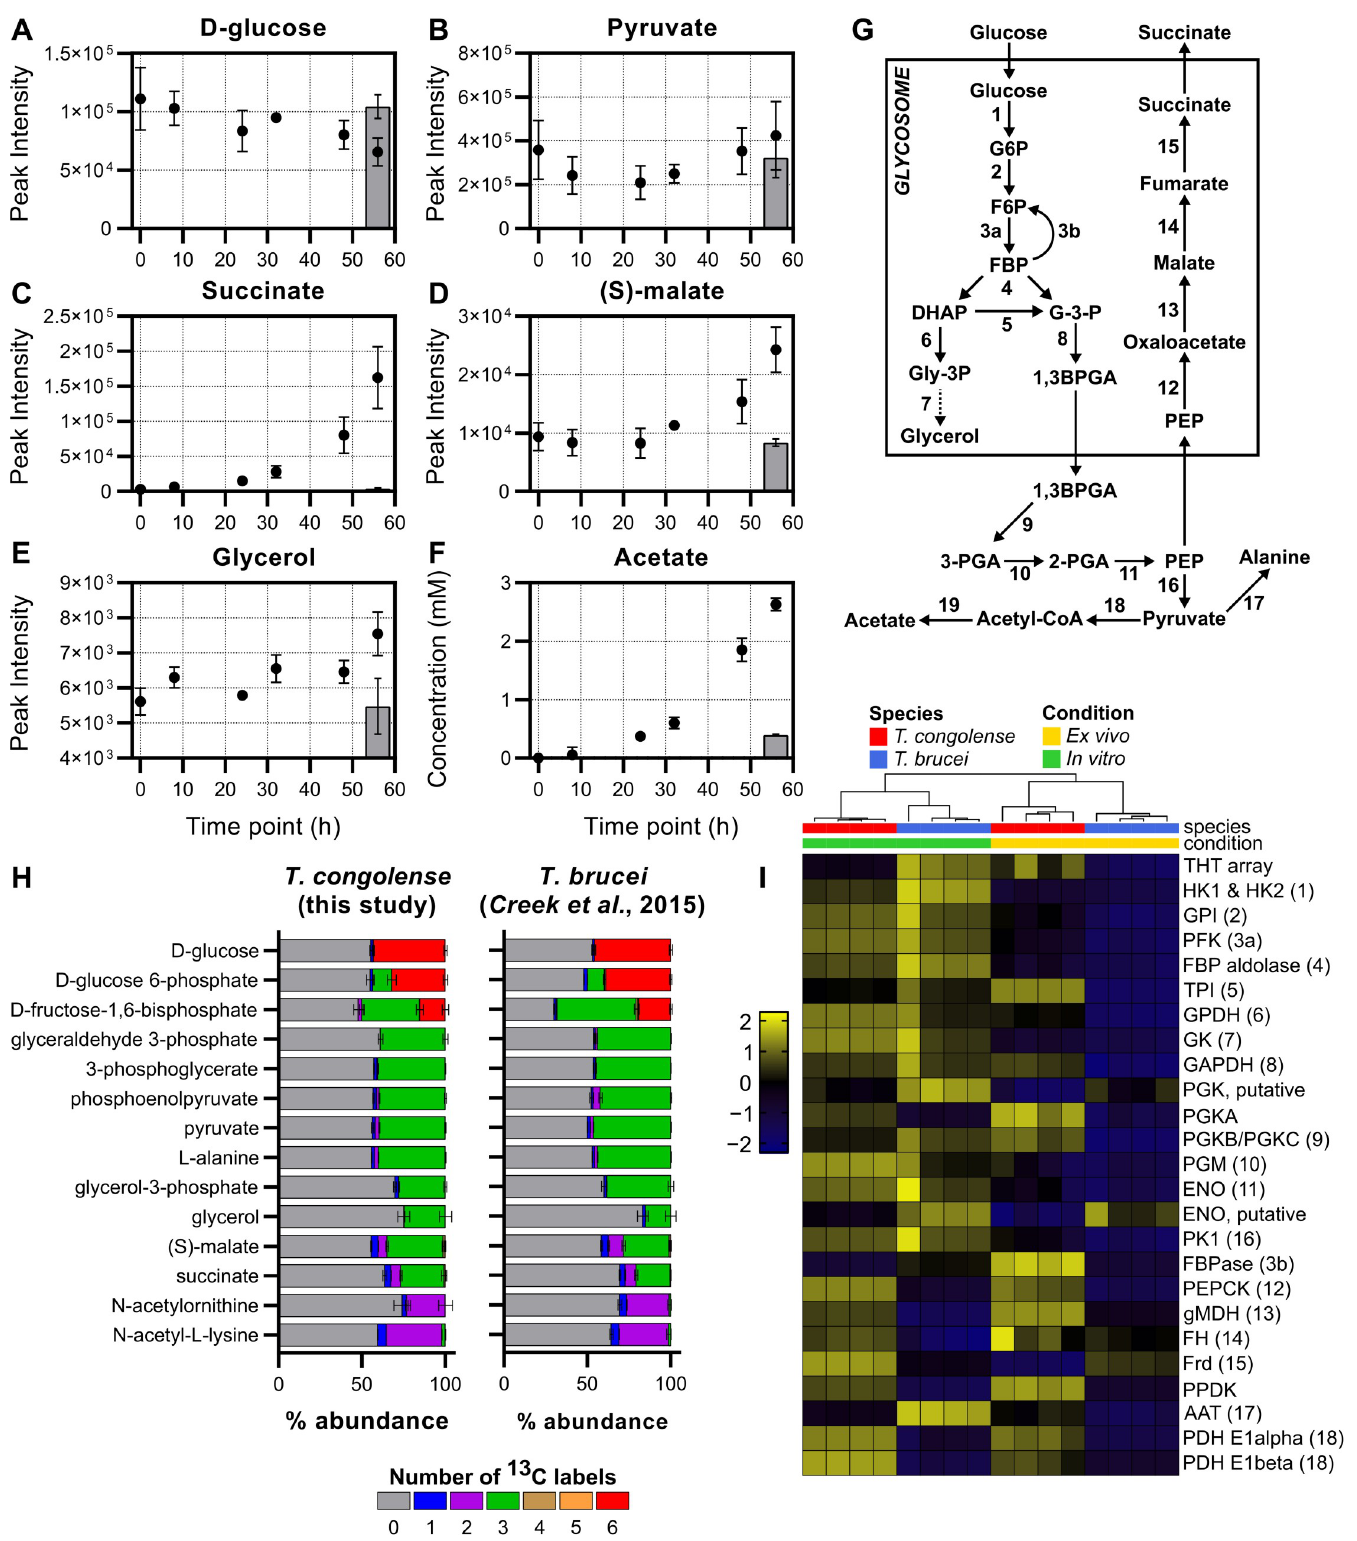
Fig 3. Energy metabolism in T . congolense . A-E) Supernatant metabolomics analysis of metabolites involved in glycolytic metabolism in T . congolense . Grey bars indicate a negative medium control incubated for 56 hours. F) A commercial kit was used to measure acetate concentration during T . congolense culture,